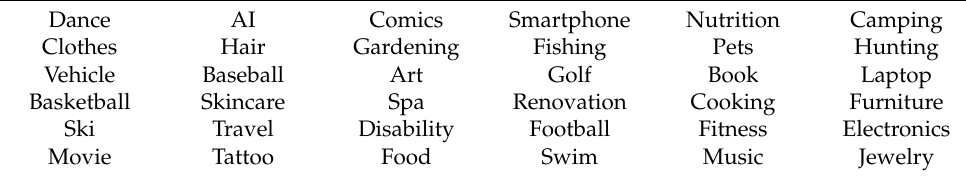
Table 1. Categories of user